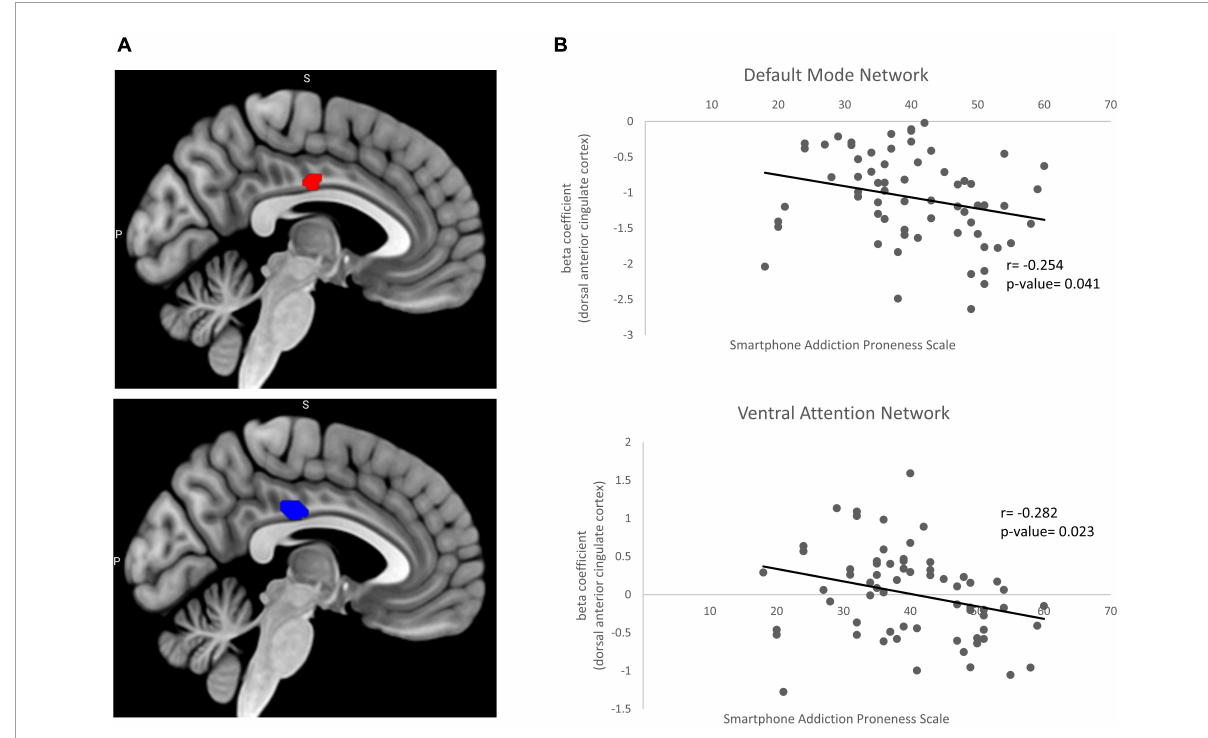
FIGURE1 Beta coefficient from two sample t -test and correlation with clinical variable. (A) Significant increases in the resting state functional connectivity of the default mode network (red) and ventral attention network (blue) in problematic smartphone users. Problematic smartphone users displayed increased resting state functional connectivity in dorsal anterior cingulate cortex in both default mode network and ventral attention network. (B) Pearson correlation analysis for correlation of beta coefficient in dorsal anterior cingulate cortex and smartphone addiction proneness scale. In default mode network, beta coefficient in dorsal anterior cingulate cortex showed negative correlation (Pearsons’s r = –0.254, p -value = 0.041). In ventral attention network dorsal anterior cingulate cortex also showed negative correlation with smartphone